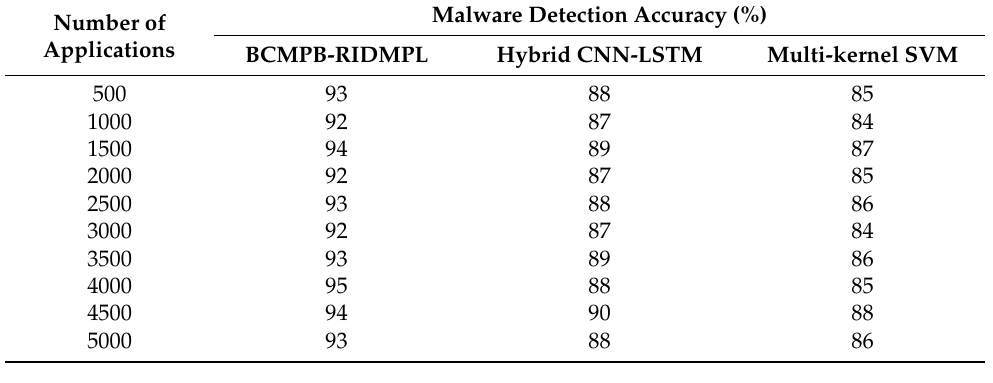
Table 2. Comparison of malware detection accuracy.